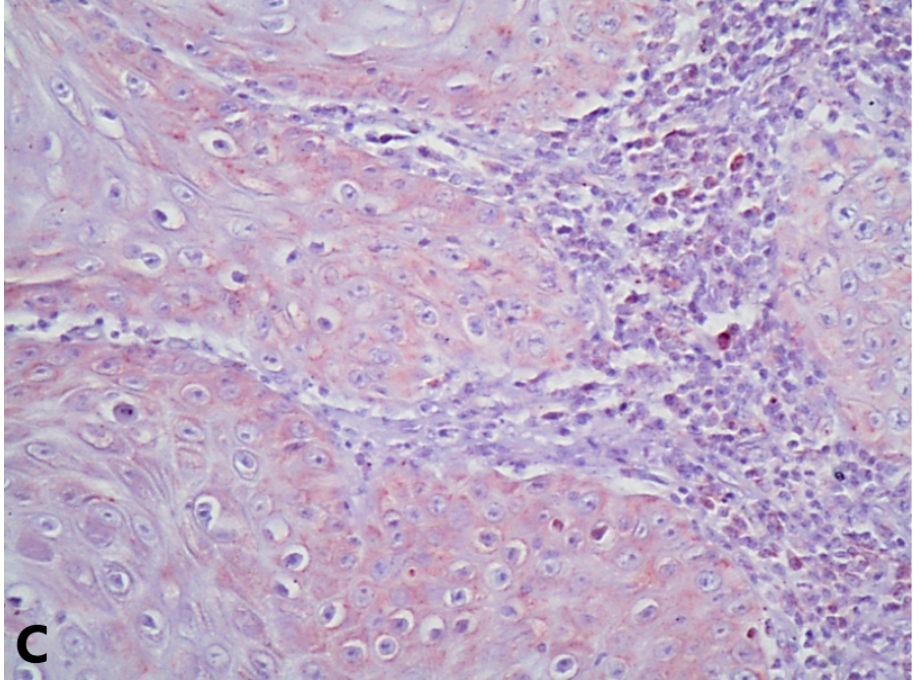
Figure 2. ( A ): A clear transition zone between normal-appearing mucosa with high VDAC1 expression and dysplastic/neoplastic mucosa with decreased VDAC1 expression (asterisk) (magnification × 100). The dysplastic grade is evaluated as “high grade”. ( B ): OSCC of the tongue showing decreased to absent VDAC1 staining of tumor islands invading the positively stained myocytes, a positive internal control (VDAC1 × 100, inset VDAC1 magnification × 200). ( C ): OSCC of the oral mucosa presenting decreased VDAC1 staining, while some inflammatory cells express VDAC1 (VDAC1; magnification ×400).